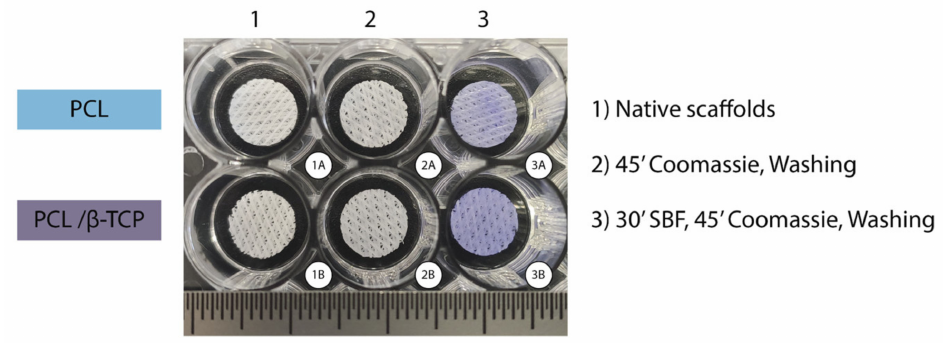
Figure 4. Coomassie Brilliant Blue test performed on PCL (upper row) and PCL/ β -TCP (bottom row) scaffolds after non-immersion in FBS (2A,B) and 30 min immersion in FBS (3A,B). Two unstained scaffolds were taken as the control